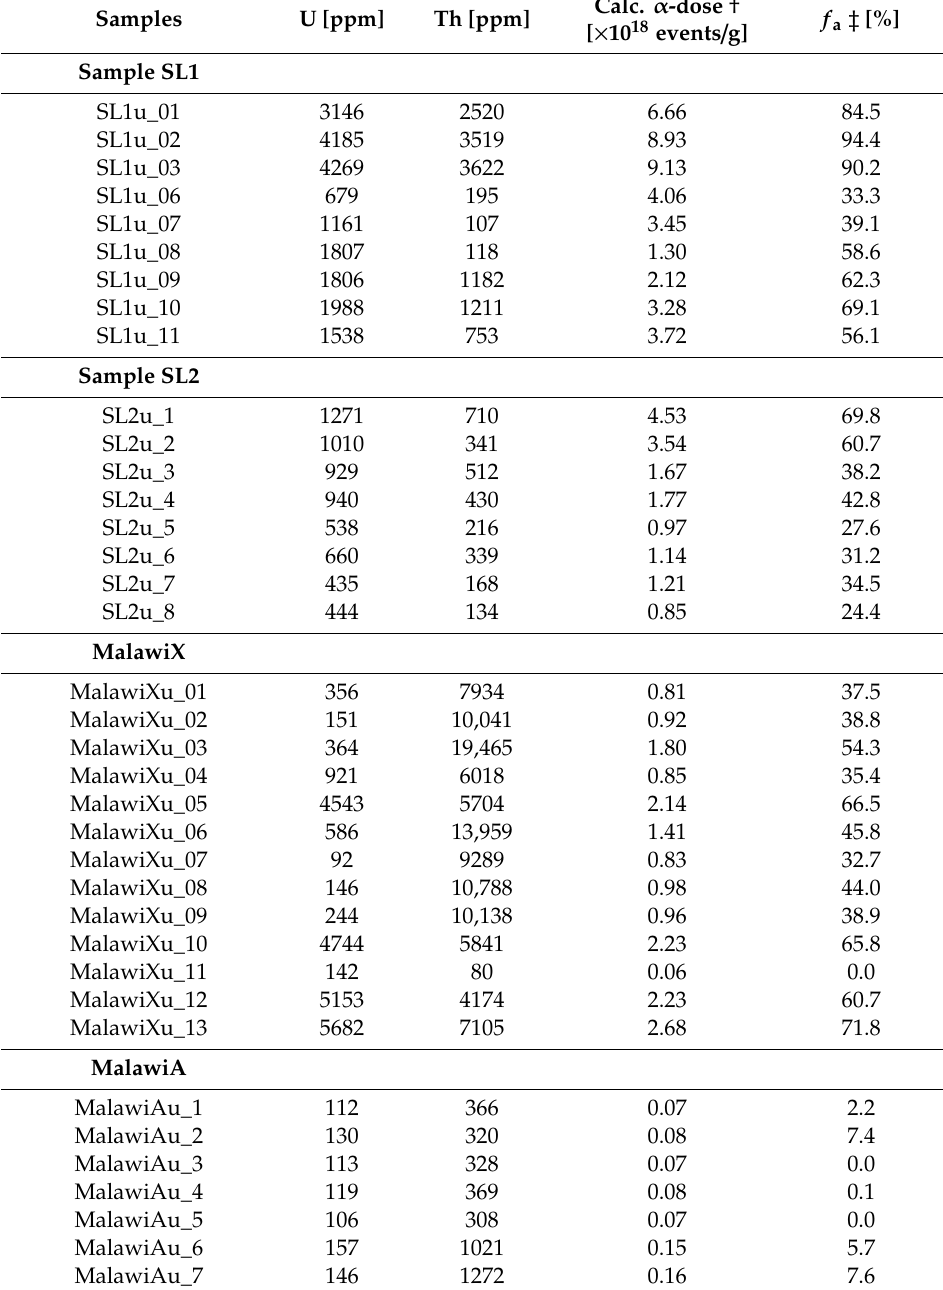
Table A2. Uranium and thorium concentrations, calculated α -doses, and the amorphous fraction f a obtained from multiple measurement spots on the unannealed (u), heterogeneous crystal halves of sample SL1 and SL2 from the Ratnapura district, Sri Lanka, and the samples MalawiA and MalawiX from the Mt. Malosa massif,